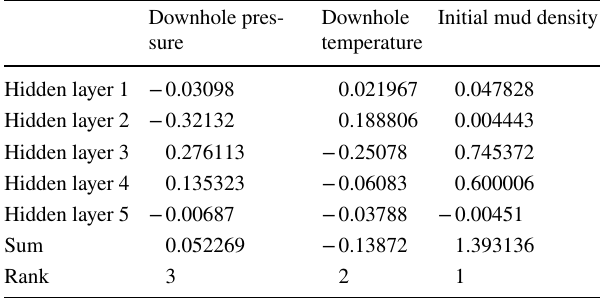
Table 9 Connection weights products, relative importance and rank of